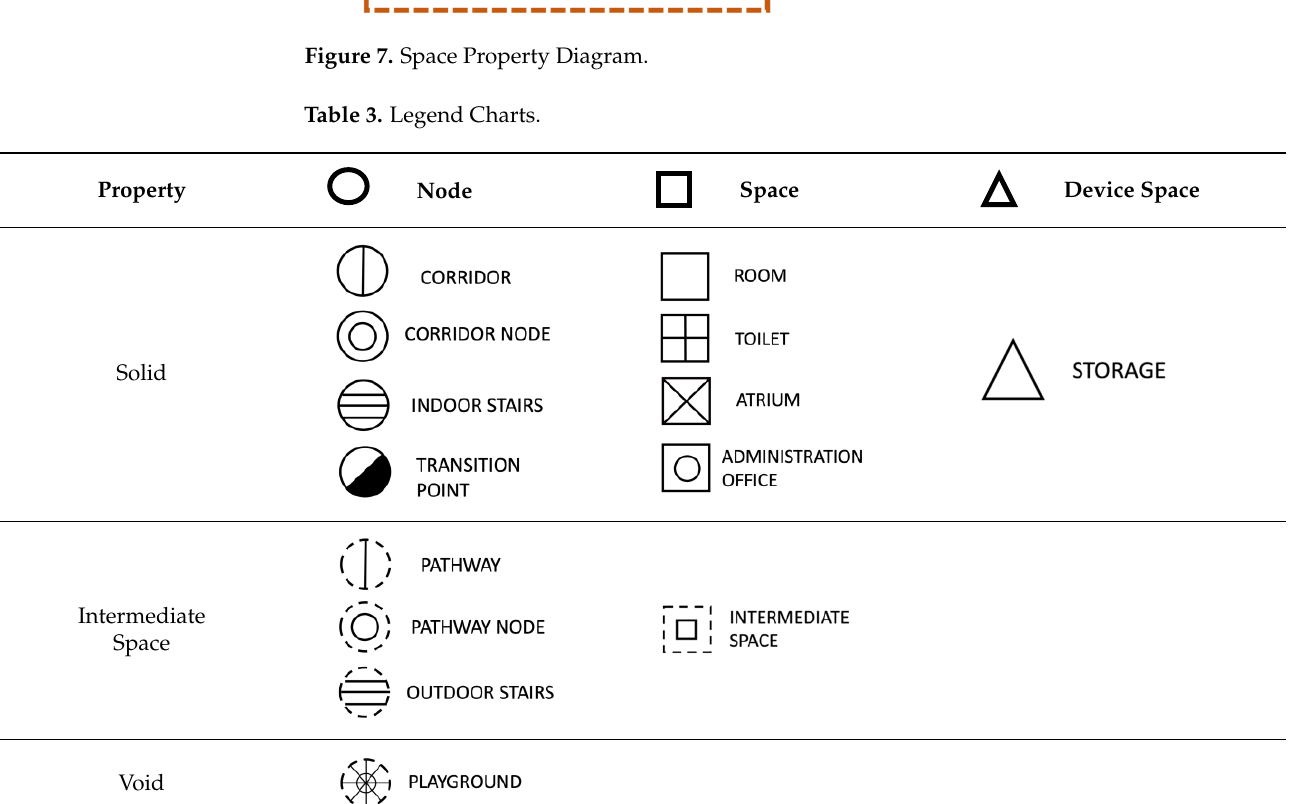
Table 3. Legend Charts.